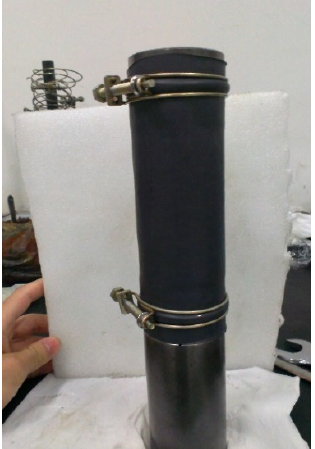
Figure 5. Covering the sample with a rubber sleeve.